Question: Which visualization type does this figure use?
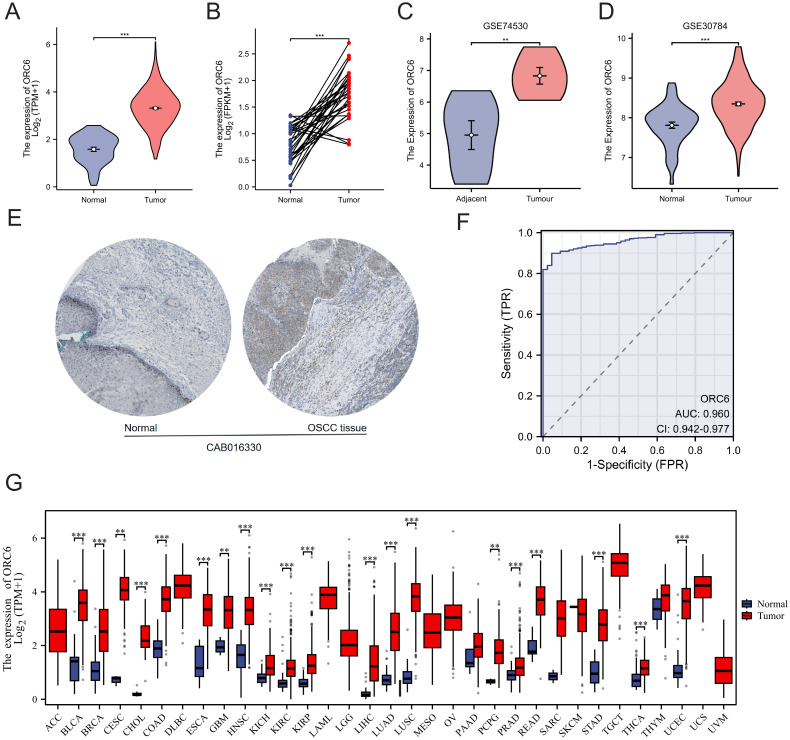
Answer: line